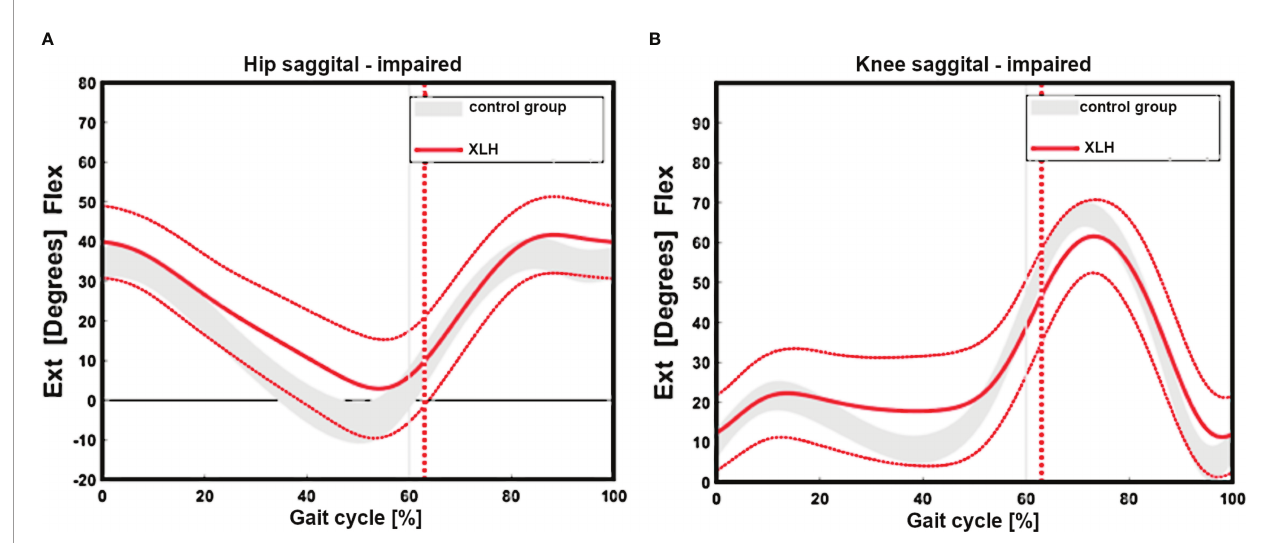
FIGURE 2 | Gait cycle analysis showing overall impaired sagittal range of motion of the hip (n = 29 patients) (reduced extension, (A) . Reduced extension during stance and fl exion during swinging of the group with XLH ( B , red line + 1 SD) versus the control group grey curved area.